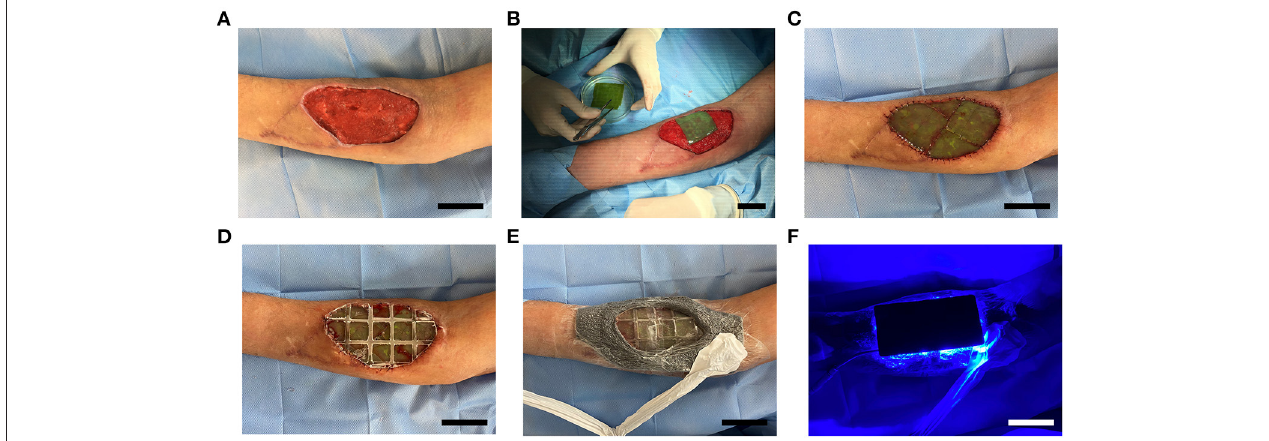
FIGURE 4 | Photosynthetic scaffold implantation. Wound bed was cleaned and prepared for scaffold implantation (A) . Photosynthetic scaffolds were sutured between them and to the wound edges (B,C) , and covered with a flexible and transparent PDMS membrane (D) , which was then secured with negative pressure wound therapy, leaving a window over the scaffold to allow illumination (E) . Light device was then placed on top and illumination intensity was controlled (F) . Scale bars represent 5cm.